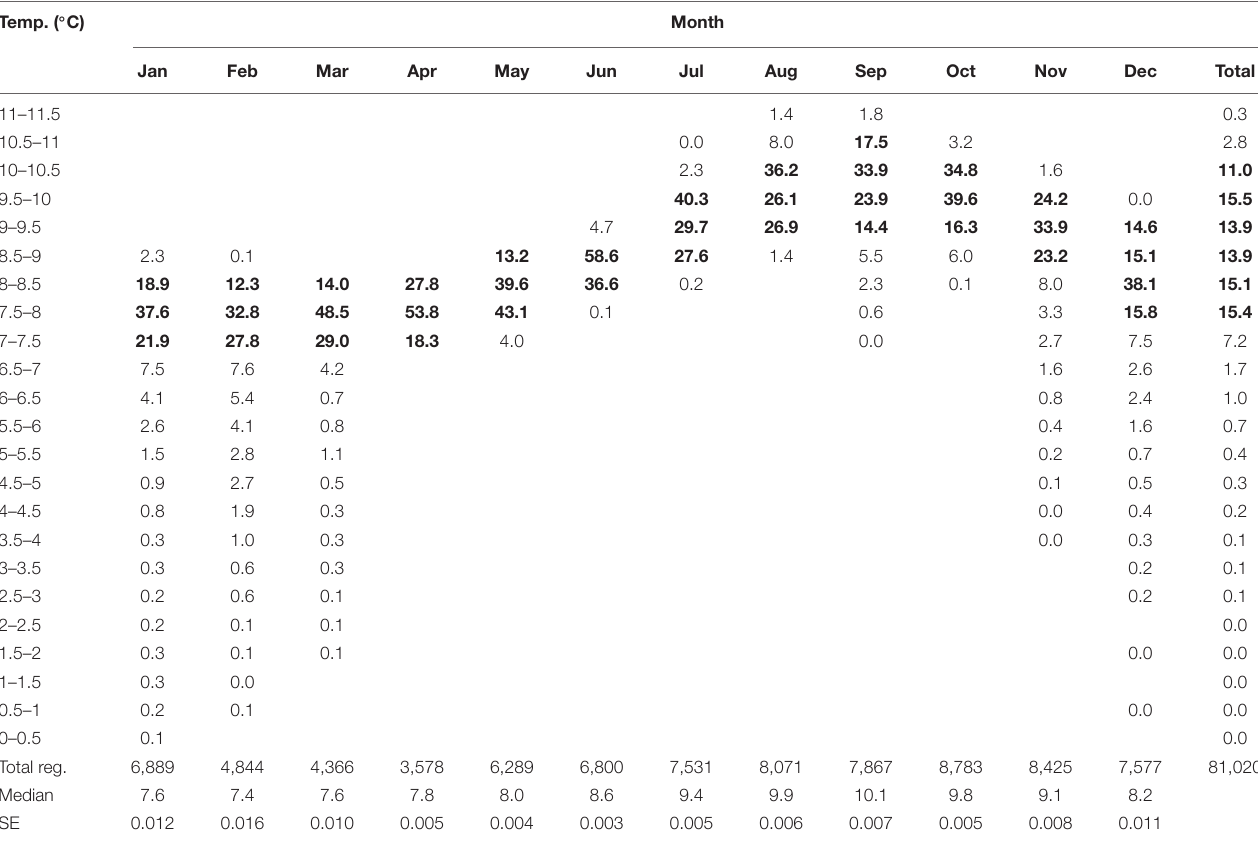
TABLE 4 | Temperature registrations once per hour as percentages of total registrations per months. Temp. ( ◦ C)